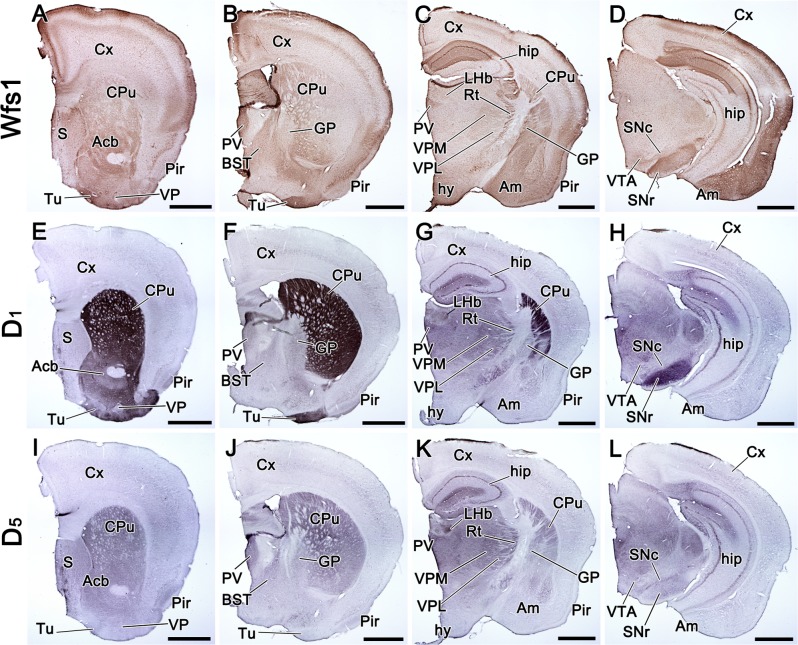
Distribution of Wfs1, D1, and D5 proteinsin the adult mouse brain.Distribution of Wfs1, D1, and D5 proteins in the adult mouse brain,shown by immunohistochemistry on coronal sections. The sections arein anterio-posterior order from left to right. The detected proteinsare indicated on the left side of the figure. Wfs1 is present in thecerebral cortex, in CA1 of hippocampus, CPu, Acb, Tu, amygdala, Rt,PV, VPM, hypothalamus and SNr (A-D). D1 is strongly present in CPu,Acb, Tu, hip, thalamus and SNr (E-H). D5 is present in CPu, Acb, S,hip, thalamus and SNc (I-L). Note that in Tu and SNr thedistribution of D1, but not D5, is similar to Wfs1. Forabbreviations, see list. Scale bar is 1 mm.